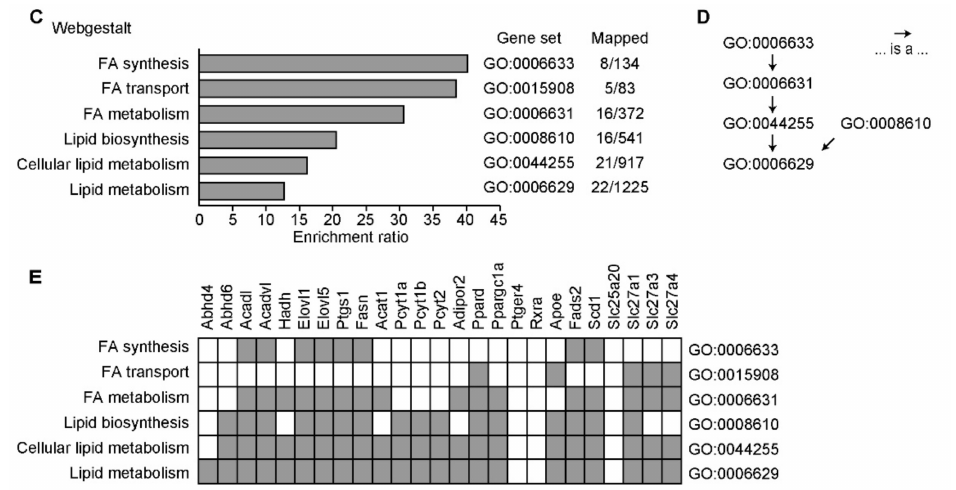
Figure 3. n-3 supplementation increases transcription of genes involved in fatty acid processes. ( A ) Heatmap of transcriptional regulation of the 89 analyzed genes presenting significant or non- significant gene modifications. Gapdh is used as the housekeeping gene (reference). Insert represents Z-scores’ distribution. ( B ) Significantly upregulated genes. Values (box and whiskers plots) are plotted from minimum to maximum. ( C ) Gene ontology (Webgestalt [35,36]) and enrichment ratios of the significantly upregulated genes induced by n-3 supplementation. Such an analysis yielded different gene ontology (GO) families, represented with their respective GO codes. Mapped terms within our study are indicated over the total number of genes within each GO family. ( D ) Redundancy of the gene ontology families. Arrows indicate inclusive relationships. ( E ) Detailed mapping of genes and ontology families. Genes were found to be either present (grey) or absent (white) from different gene ontology families. Ptger4 was linked to 8 families from the top 50 enriched ones, while both Rxra and Slc25a20 were not mapped amongst the top 50 enriched